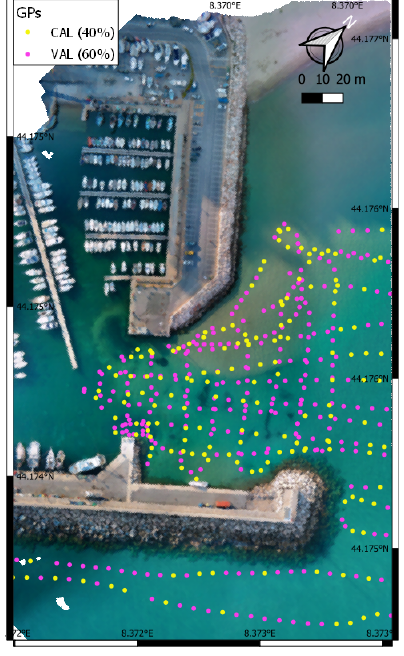
Figure 6. Capo San Donato SBES point sets used for calibration (40%—in yellow) and validation (60%—in pink) of the RDB method applied to the UAV, aircraft and S-2 orthophotos.